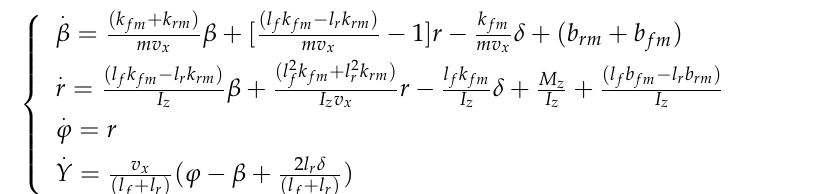
angle at wheels are represented: